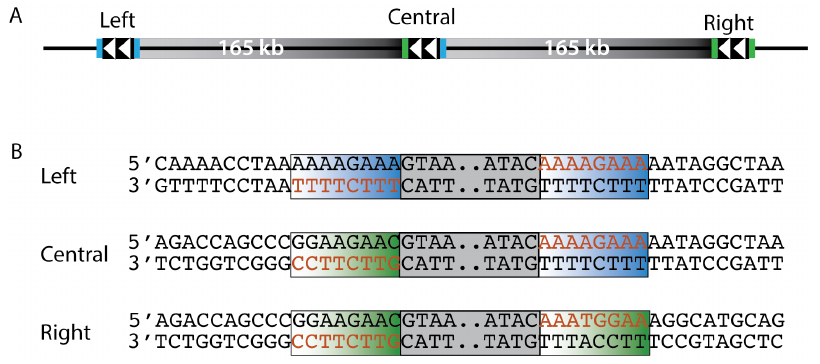
Figure 3. ISPsy5 target site duplications. A. Target site duplications associated with each ISPsy5 element in the 165 kb tandem duplication are predicted to have the structure depicted here. The blue and green rectangles correspond to the 8 bp target site duplications associated with the left and right ISPsy5 elements. The central element is a hybrid of the right and left target sites. B. The target site sequences (blue and green shading) for each ISPsy5 element (gray box, only 4 terminal base pairs are shown) in the 165 kb duplication were determined by Sanger sequencing PCR products that cover each loci.